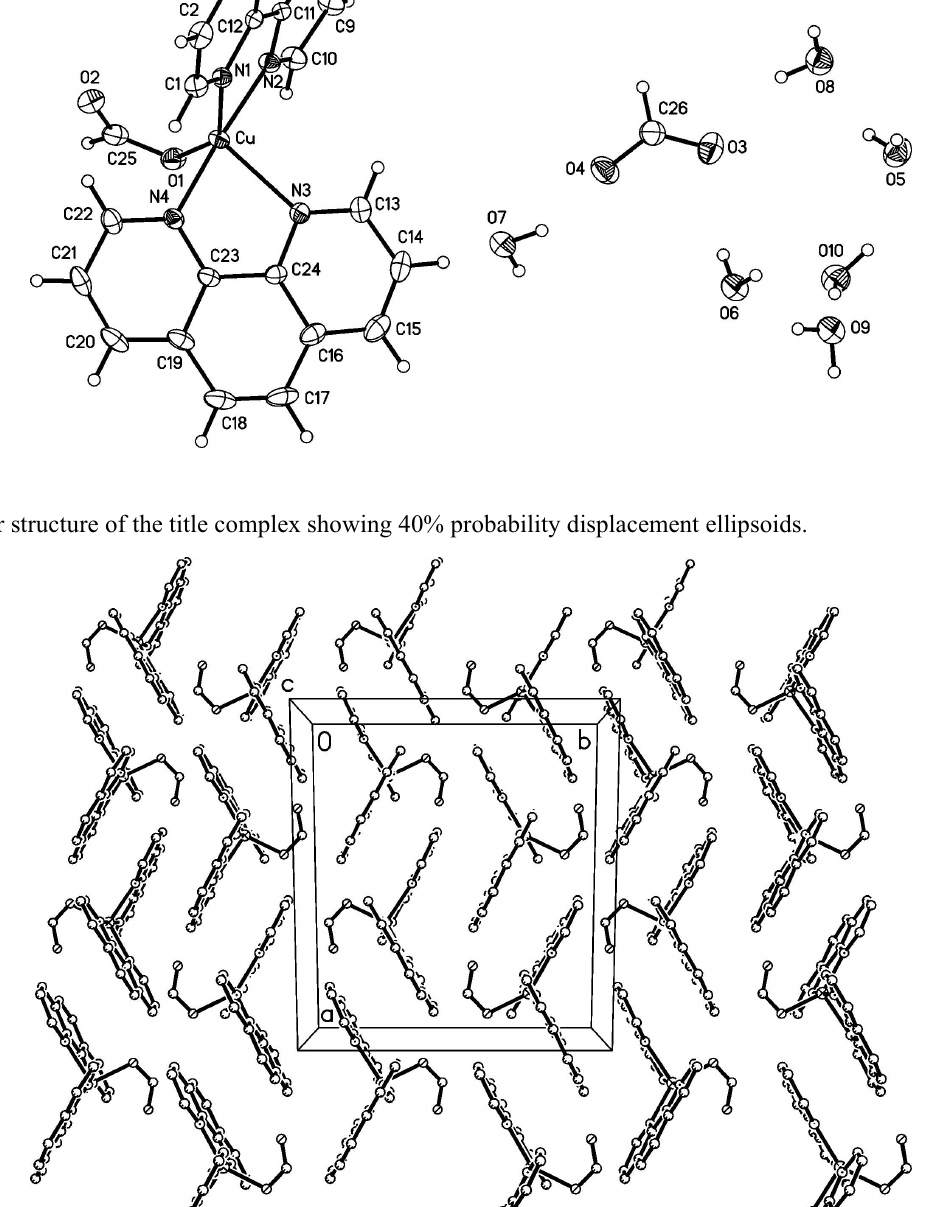
(HCOO)] + complex cations based on π - π stacking 2